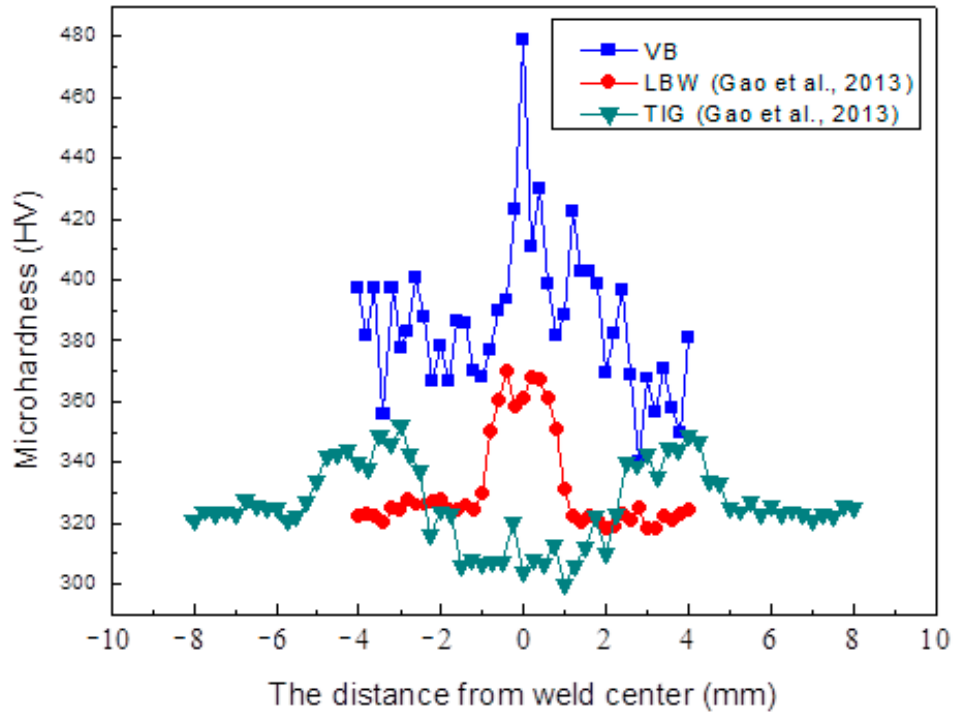
Figure 9. Microhardness distribution of A3B3C1D3 specimen.